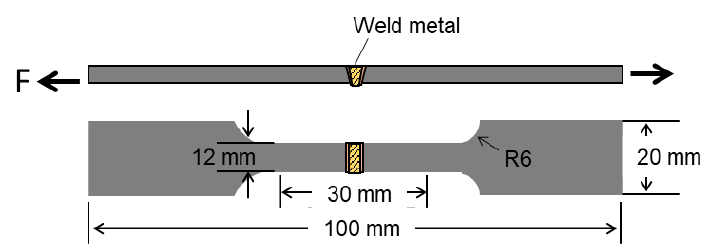
Figure 3. Configuration of tensile test specimen.